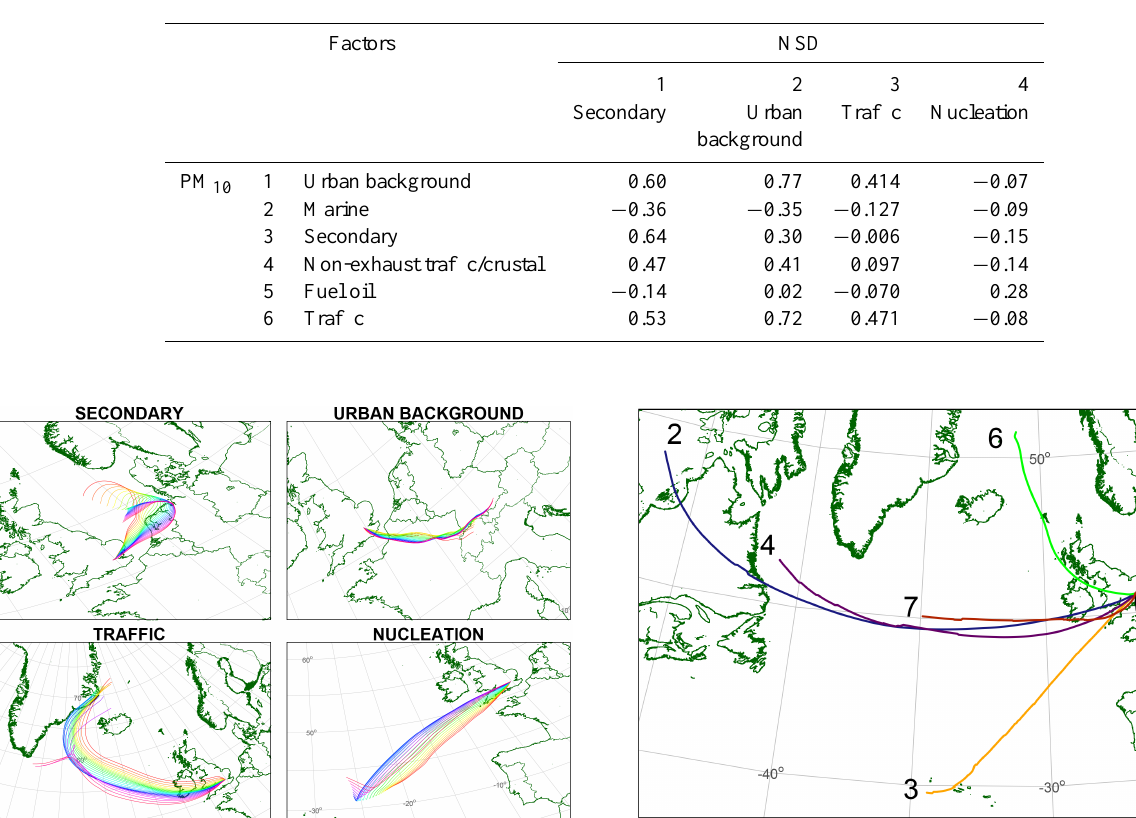
Table 3. Pearson correlation coefficients between the daily average NSD and PM 10 factors.